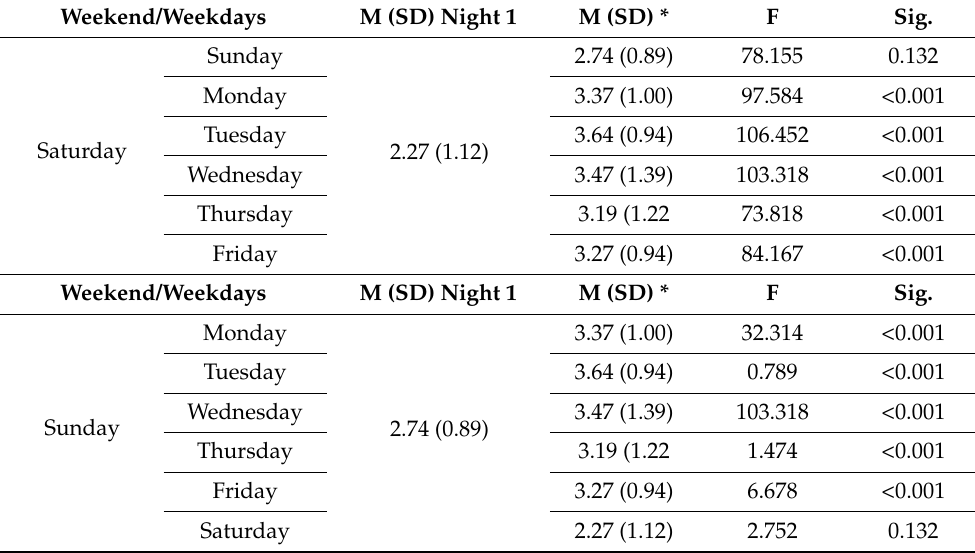
Table 3. Examining weekend effects on quality of bedtime